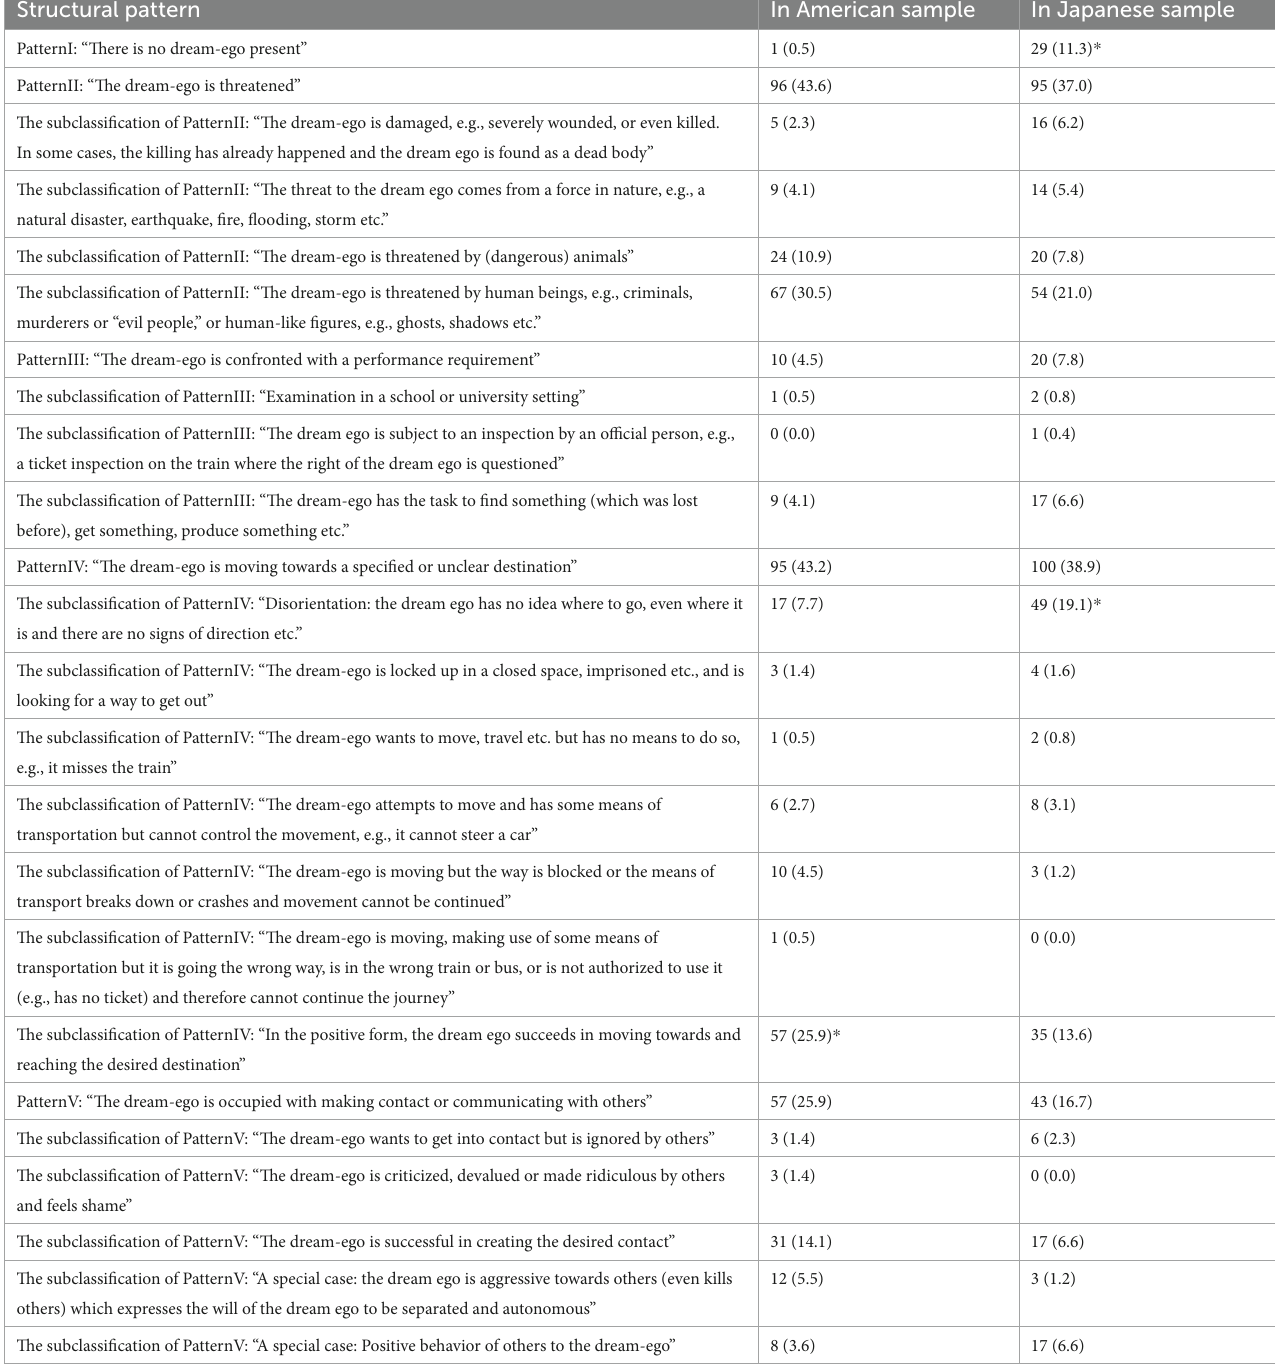
TABLE 4 The rate of incidence of each structural pattern in the American and Japanese samples for “impressive dreams in childhood”. Structural pattern In American sample In Japanese